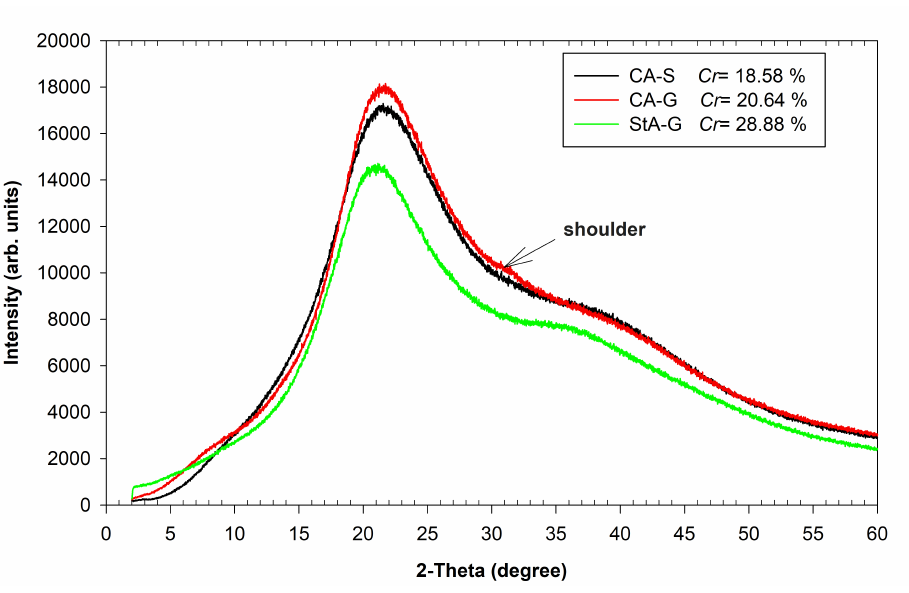
Figure 5. Diffraction patterns and percent crystallinity ( Cr ) of biopolymeric films: CA-S ( ), CA-G ( ), StA-G ( ). The arrow indicates a shoulder in the CA-G